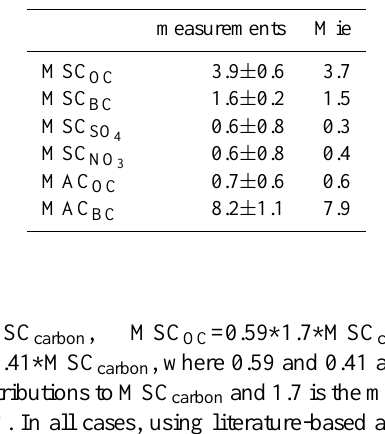
Fig. 2. Apportionment of PM 2 . 5 aerosol mass concentrations for (a) extratropical southern Africa and (b) tropical southern Africa. Shown are the median percent contributions of organic matter (OM), black carbon (BC), ammonium nitrate (AN), and ammonium sulfate (AS). aerosol mass concentrations for (a) extratropical southern Figure 2. Apportionment of PM 2.5 ABS = M OC ∗ MAC OC + M BC ∗ MAC BC Table 6. The mass scattering cross sections for organic carbon Africa and (b) tropical southern Africa. Shown are the median percent contributions of ) , and nitrate (MSC OC ) , black carbon (MSC BC ) , sulfate (MSC SO 4 ) and the mass absorption cross sections for organic car- (MSC NO organic matter (OM), black carbon (BC), ammonium nitrate (AN), and ammonium sulfate 3 bon (MAC OC ) and black carbon (MAC BC ) , as derived from mea- (AS). surements and from Mie theory. The units are m 2 /g and MSC and MAC are at a wavelength of